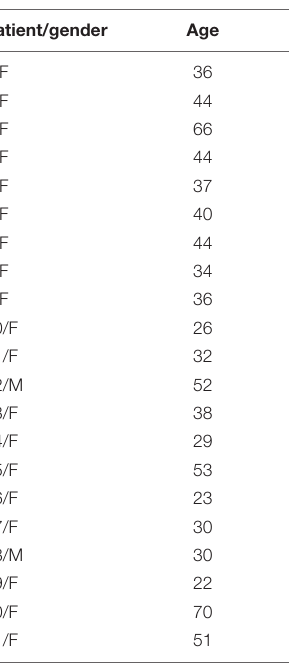
TABLE 1 | Demographic and clinical data for